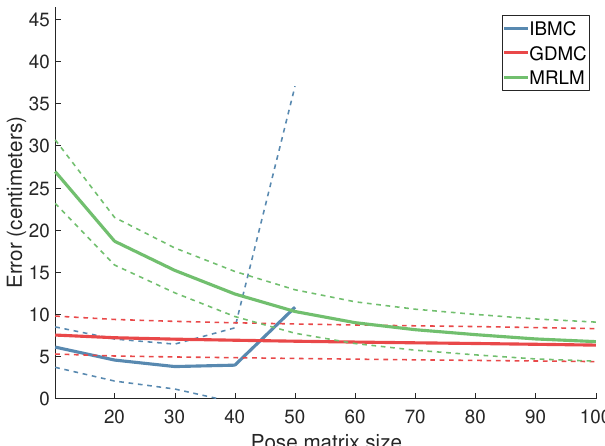
Figure 3. Error as a function of the pose matrix size. We vary the size N of the pose matrix (which consists of the N closest poses selected from the pose database) and measure the resulting average error per joint, per completed pose. While GDMC and MRLM continue to improve with more evidence, IBMC exhibits a basin and becomes unstable after ~50 poses. The dashed plots represent the standard deviation of the respective techniques.